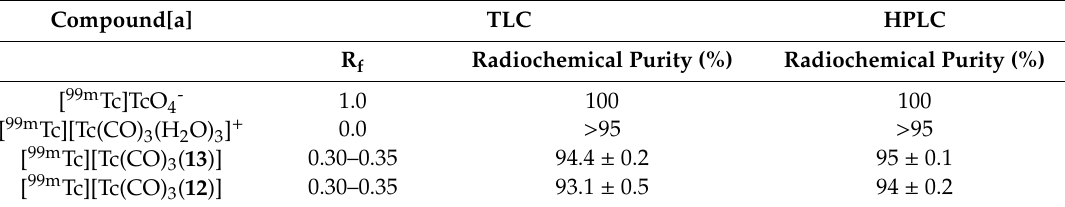
Table 1. TLC results for the quality control of the radiolabeled conjugates [ 99m Tc][Tc(CO) 3 (L)] (L = 12 , 13 ; n = 2–3 in duplicates). Silica gel 60 F 254 aluminum plates were used as stationary phase and a